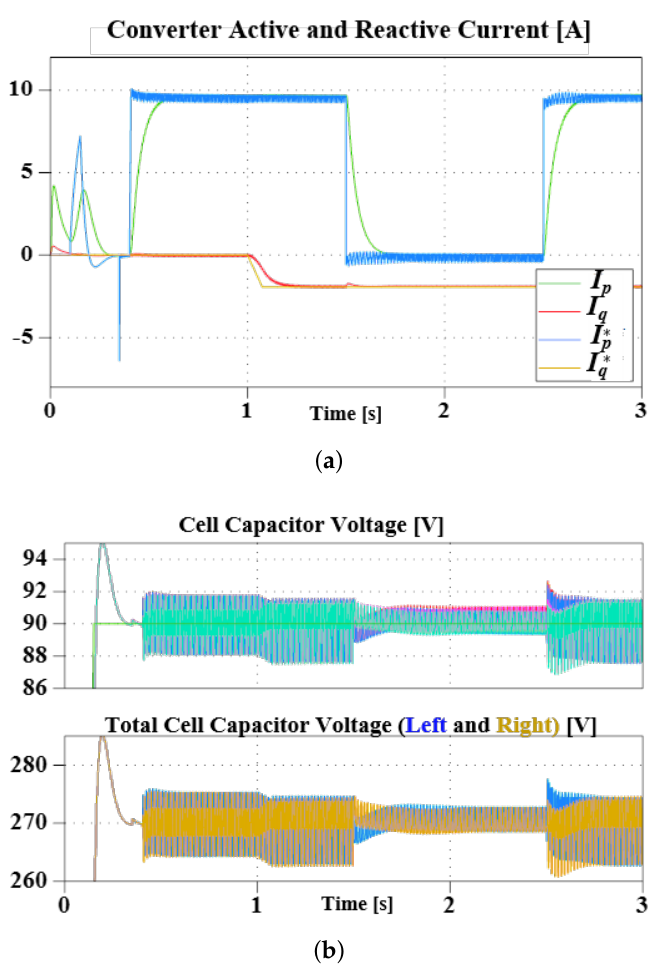
Figure 8. Simulation showing converter active and reactive current ( a ), and arm capacitors voltages during transients and steady state ( b